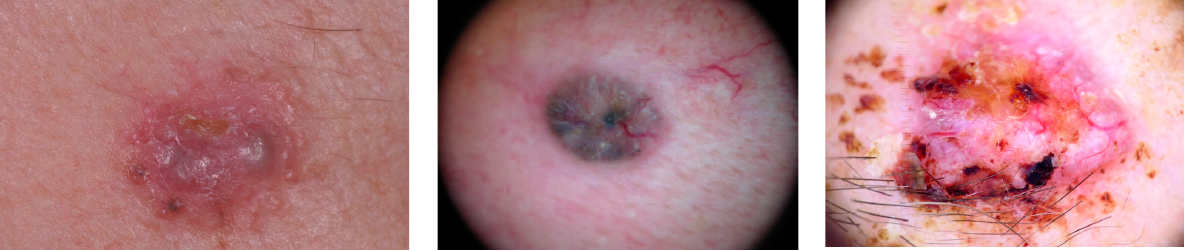
Figure 1. ISIC BCC image samples (Challenge 2018).